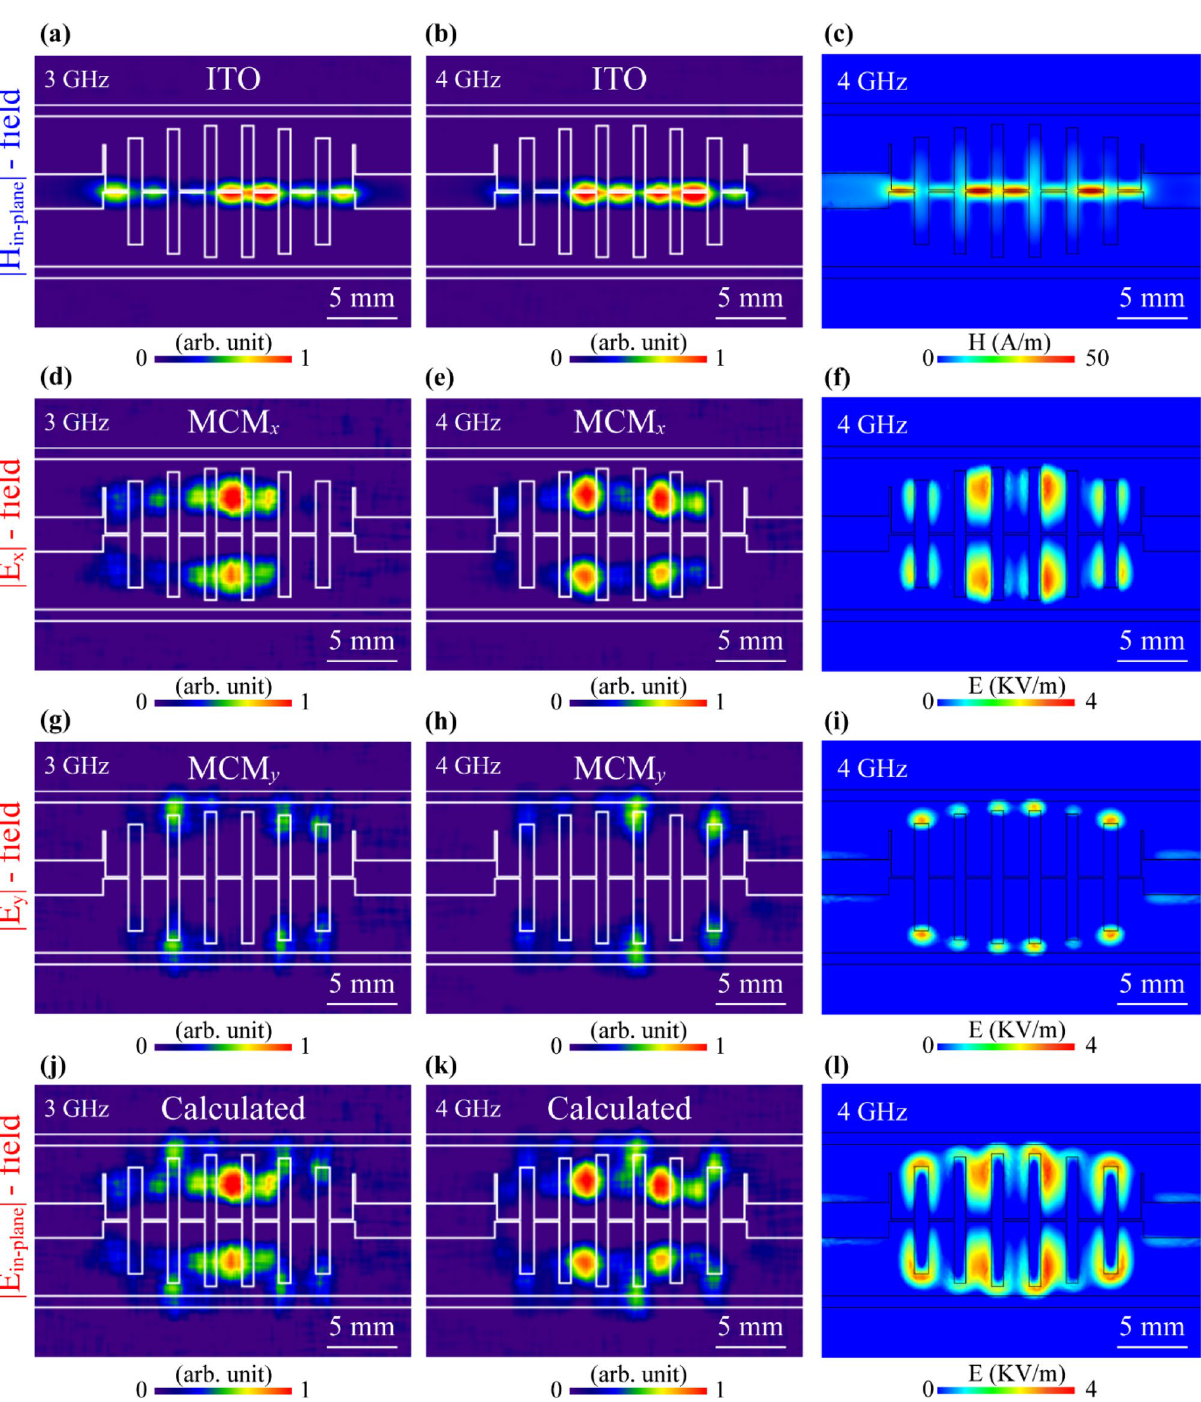
Figure 4. Visualized and simulated distributions of the electric and magnetic fields of LPF. The first row represents the visualized and simulated results for in-plane magnetic field distributions (| H in-plane |) using ITO glass indicator at ( a ) 3 GHz and ( b ) 4 GHz. ( c ) Simulation result corresponding to ( b ). The second row represents the visualized and simulated results for the x -component of electric field distribution (| E x |) using MCM x -metasurface at ( d ) 3 GHz and ( e ) 4 GHz. ( f ) Simulation result corresponding to ( e ). The third row represents the visualized and simulated results for the y -component of electric field distribution (| E y |) using MCM y -metasurface at ( g ) 3 GHz and ( h ) 4 GHz. ( i ) Simulation result corresponding to ( h ). The fourth row represents the calculated and simulated results for the in-plane electric field distribution (| E in-plane |) at ( j ) 3 GHz and ( k ) 4 GHz. ( l ) Simulation result corresponding to ( k